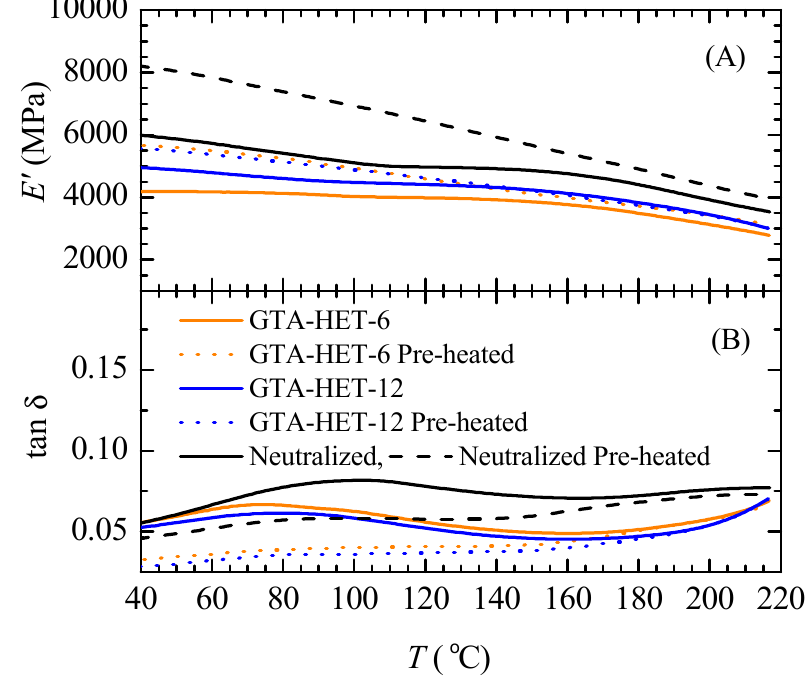
Figure 6. The plots of ( A ) storage modulus and ( B ) tan δ against temperature of non-preheated and preheated scans of 6 and 12% GTA-HET films.